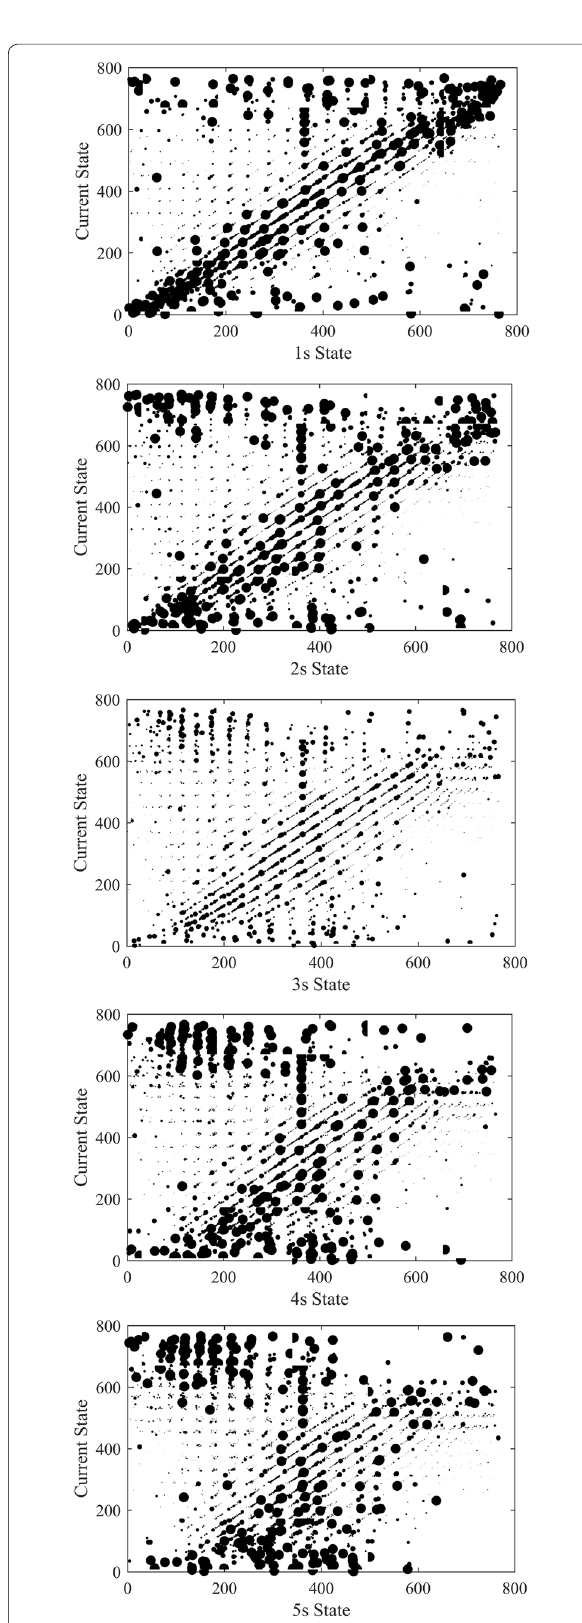
Figure 6 Future 1 ‒ 5 s state transition probability